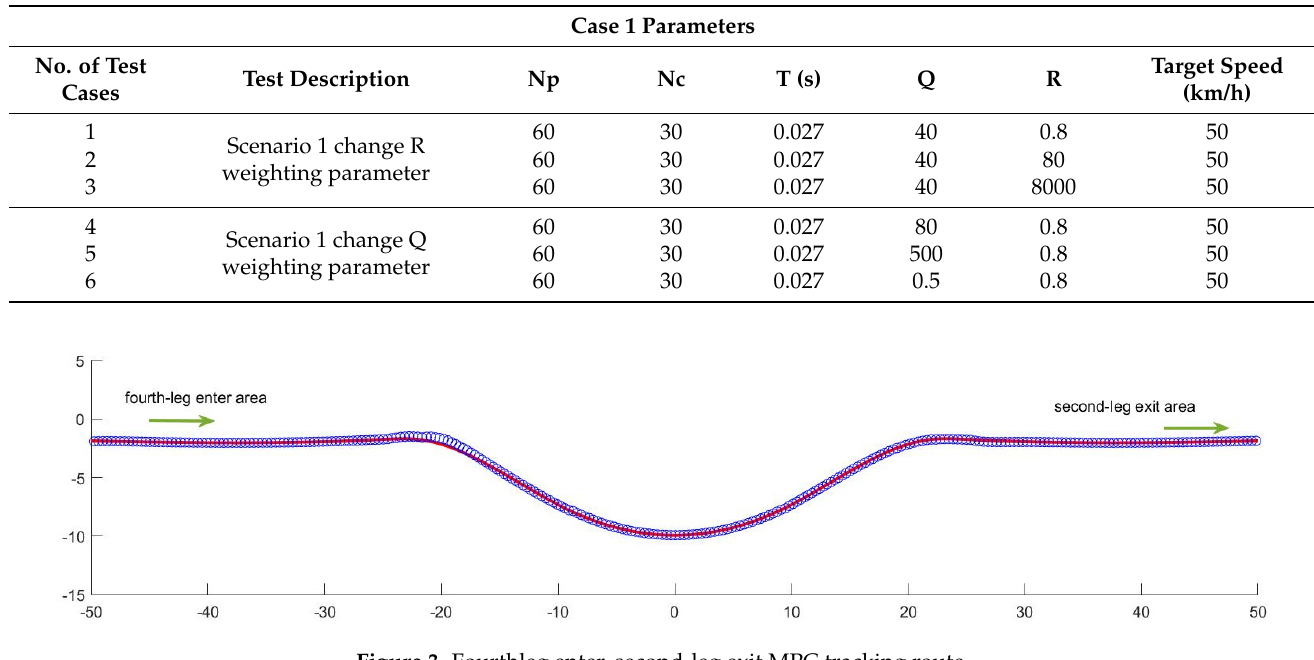
Figure 3. Fourthleg enter, second-leg exit MPC tracking route. The tracking controller performs well when the ego vehicle is going along the straight road and stable curvature curve area. The tracking performance is altered mainly in the two merging zones of the roundabout. Both Figure 4a,b emphasize their tracking differences on the lateral axis when the ego car is approaching the roundabout merging zones. When changing the parameter R, the blue line (Q = 40, R = 0.8) in Figure 4a is the most stable line and is also closer to the reference trajectory. Figure 4b demonstrates that the pink line, Q = 80, R = 0.8, is the most stable tracking route even in the merging zones. The specific tracking error on longitudinal and later directions are shown in Figure